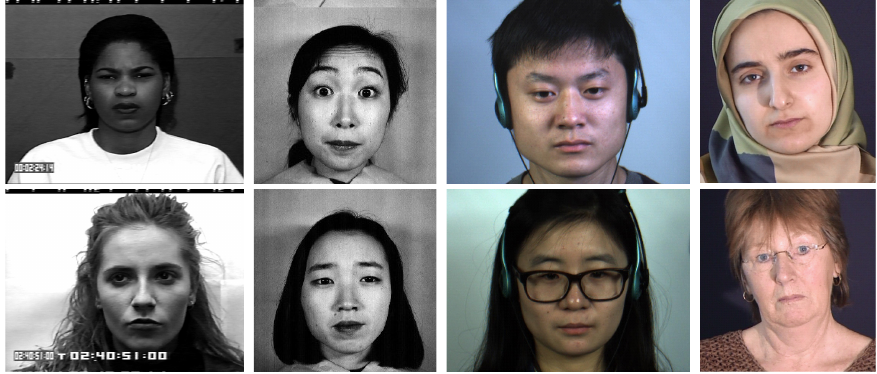
Figure 1. Datasets with different genders, races, and